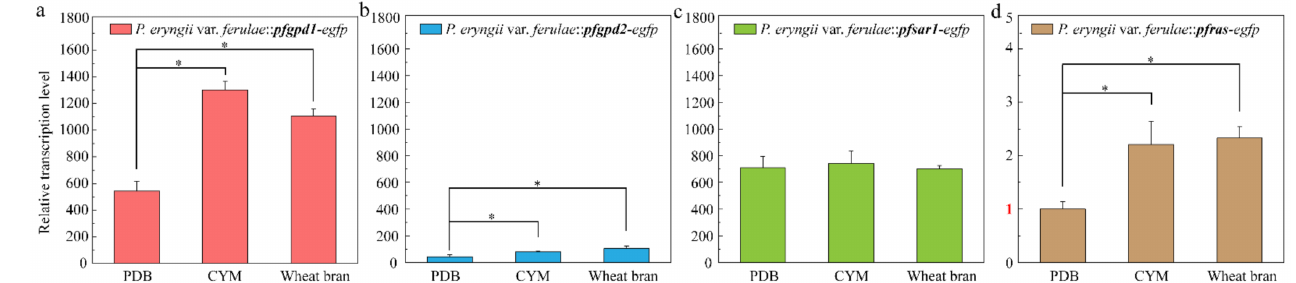
Figure 6. Determination of egfp transcription level from four transformants under different culture conditions. The egfp gene transcription in P. eryngii var. ferulae :: pfras - egfp cultured in PDA was used as the control. The relative fold change denotes the ratio of other samples to this sample. ( a ) P. eryngii var. ferulae :: pfgpd1 - egfp ; ( b ) P. eryngii var. ferulae :: pfgpd2 - egfp ; ( c ) P. eryngii var. ferulae :: pfsar1 - egfp ; ( d ) P. eryngii var. ferulae :: pfras - egfp . * p <